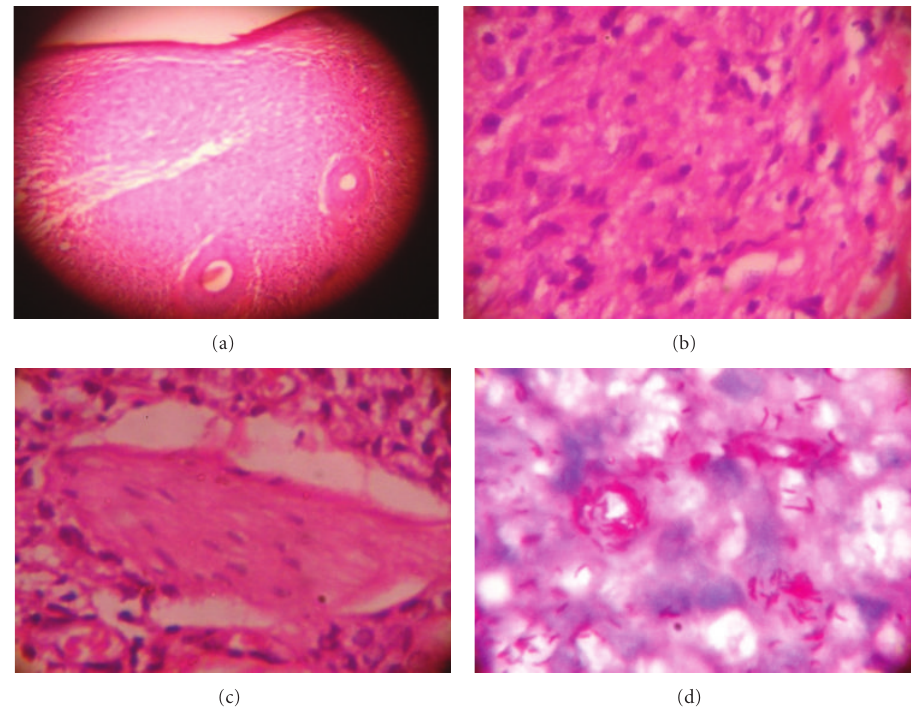
Figure 2: (a) Atrophic epidermis with underlying histoid nodule mimicking benign fibrohistiocytic lesion. Narrow grenz zone and intact hair follicle are appreciable (Leishman, × 40); (b) Leproma at higher magnification depicting spindle-round-polygonal cells (Leishman, × 400); (c) Leproma depicting intact small dermal nerve entrapped within spindle-polygonal vacuolated cells (Leishman, × 400); (d) Myriads of AFB-clusters and singly scattered (Ziehl Neelsen, ×